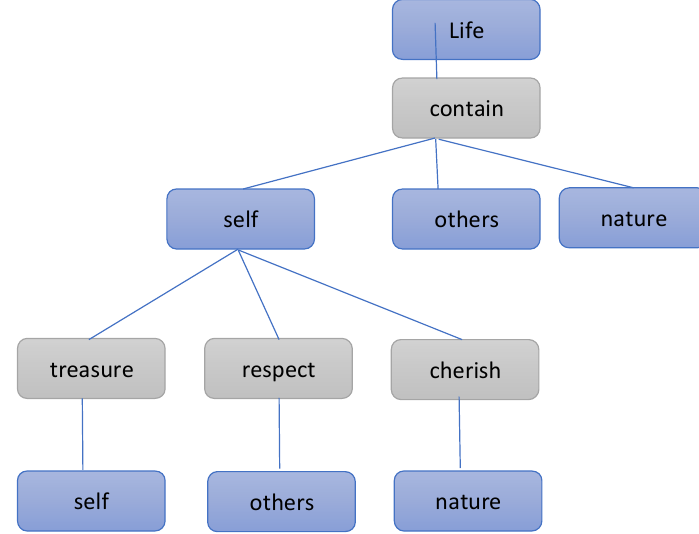
Figure 1. Life diagram. (Source: Developed in this study).